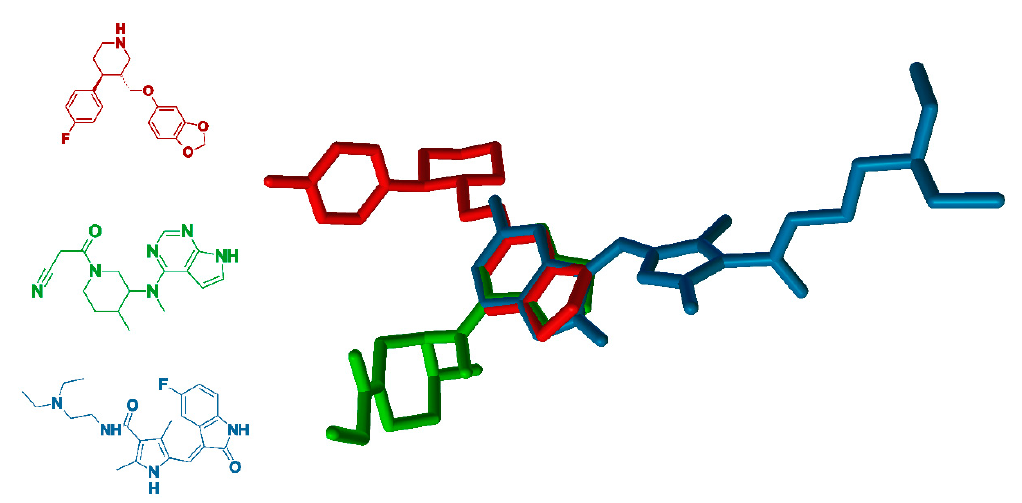
Figure 6. Superimposing of the paroxetine with selected tyrosine kinase (KIT) and Janus kinase (JAK) structure inhibitors: paroxetine (ATC code: N06AB05 [146], SSRI inhibitor, red), sunitinib (ATC code: L01XE04; [146] KIT inhibitor, blue) and tofacitinib (ATC code: L04AA29 [146], JAK inhibitor, green).